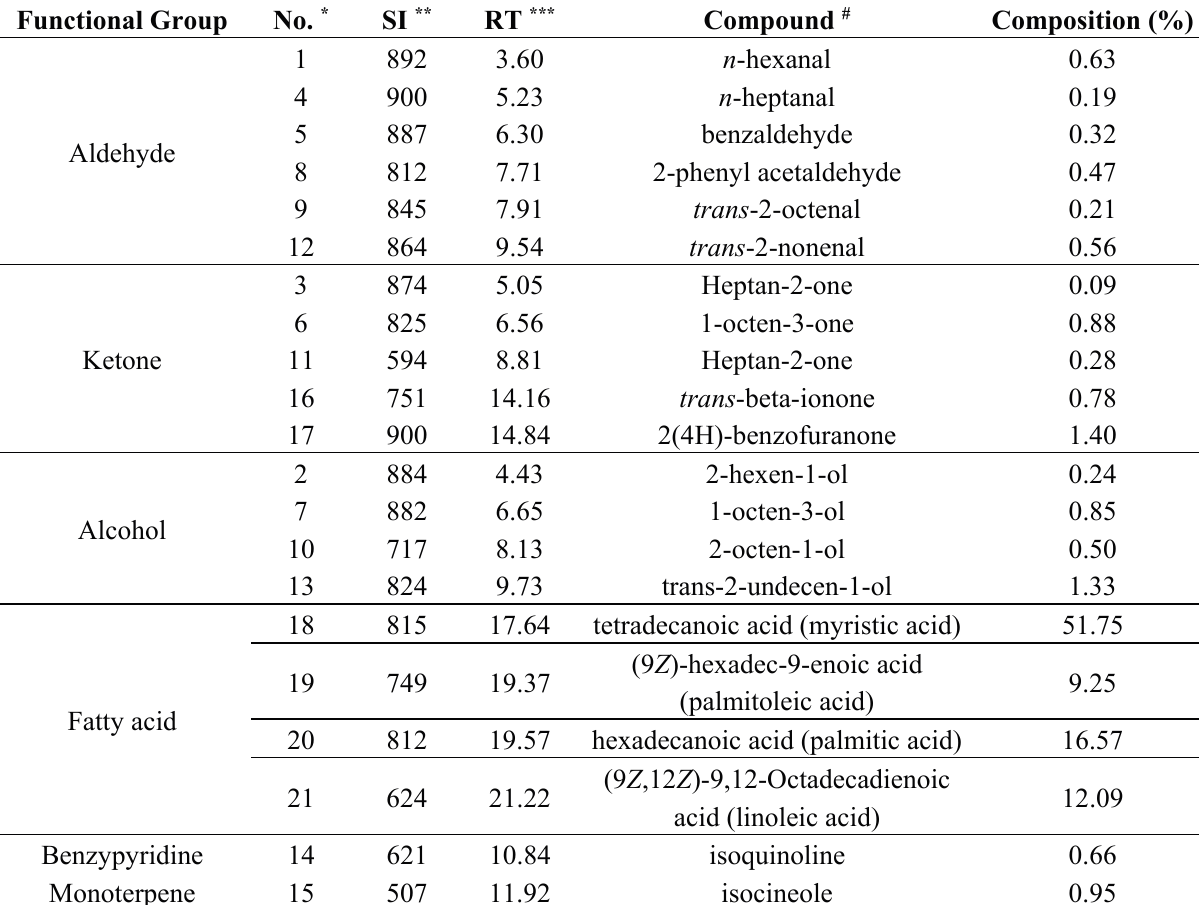
Table 1. Chemical constituents of Laminaria japonica L. essential oil (LJEO), based on GC-MS